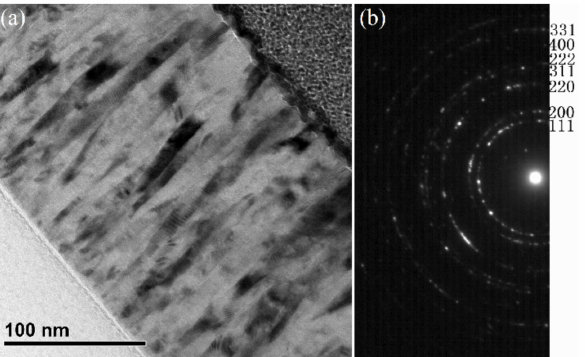
Figure 2. Bright field TEM image ( a ) and the electron diffraction pattern ( b ) of NiO thin films deposited with 11 sccm O 2 on Si (100)